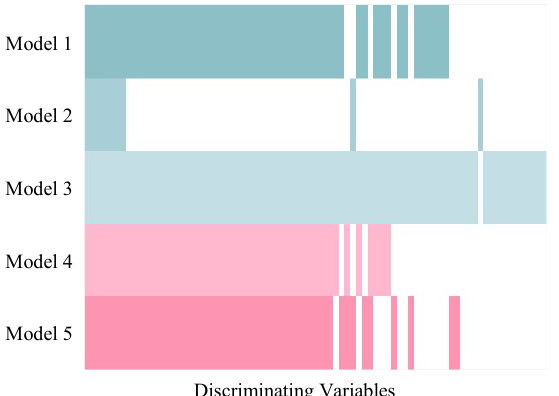
Figure 5. Comparison among discriminating variables selected by five PLS models in simulated Dataset 3. The coloured and white strips represent true positives (selected discriminating variables) and false negatives (unselected discriminating variables), respectively. The discriminating variables were arranged in order so that the variables selected by all five models were on the left side and the variables selected only by one model were on the right side.